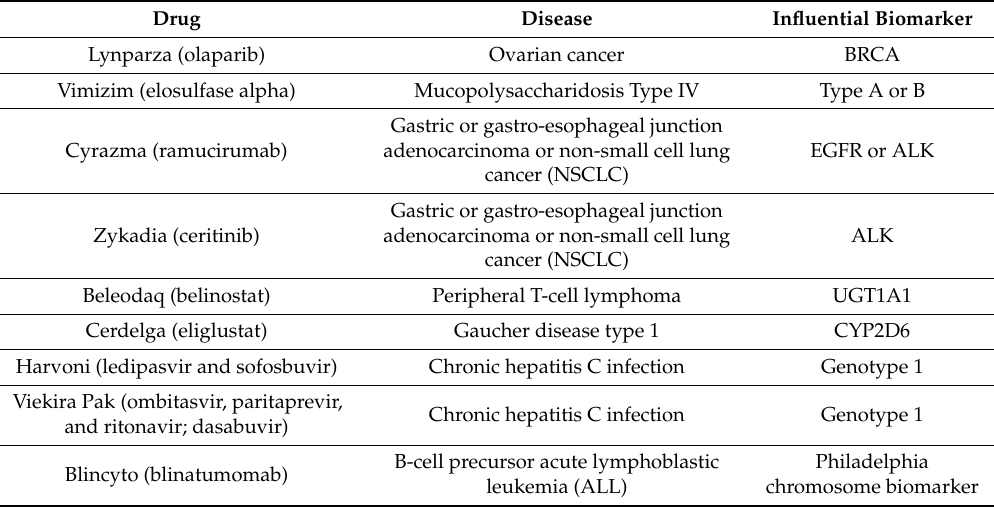
Figure 4. Use of human cells for stem cell-based assays and therapies. The embryonic stem cells (ESCs), fetal stem/progenitor cells (FSCs), adult stem/progenitor cells (ASCs) and induced pluripotent stem cells (iPSCs) used in regenerative medicines. These stems cells cultured and reprogrammed to desired cell type. After differentiation obtained desired cell types studied and tested for treating different diseases including autoimmune diseases, neurological diseases, cardiovascular diseases, degenerative skeletal diseases and cancer. Table 2. FDA approved personalized medicines in 2014.